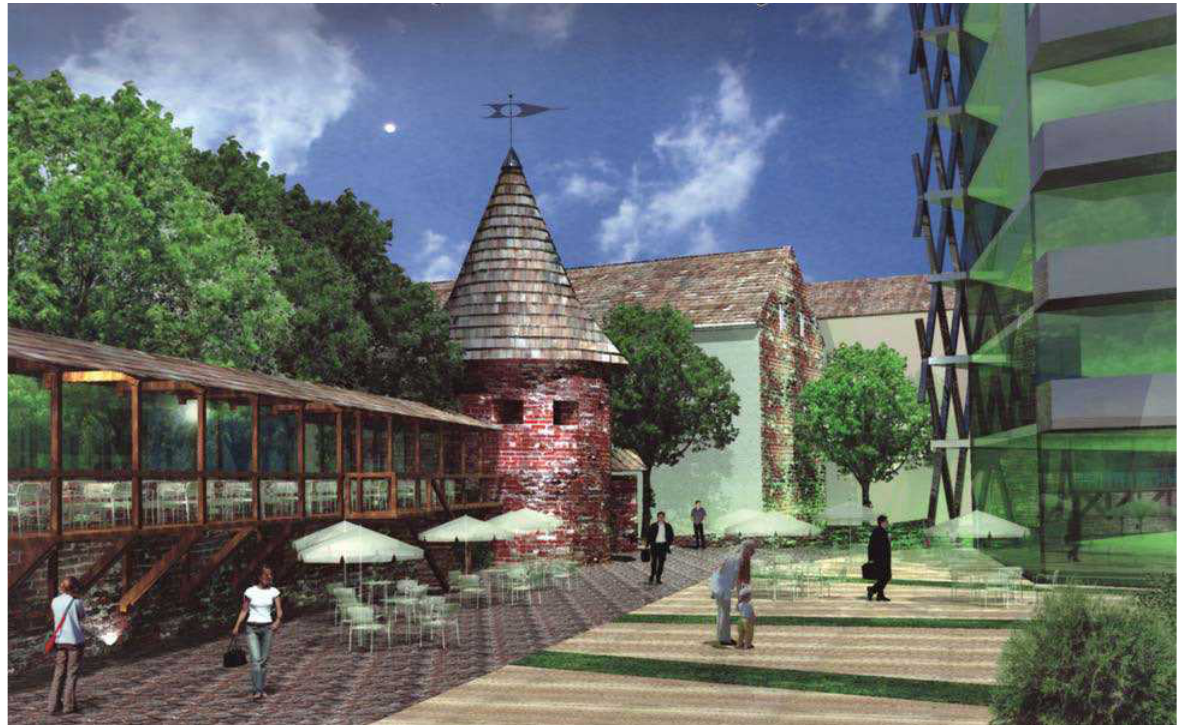
Fig 4. Visual and mental exposition of Kaunas Town Defensive Wall and Millman Tower to provide for public use function to the object and location